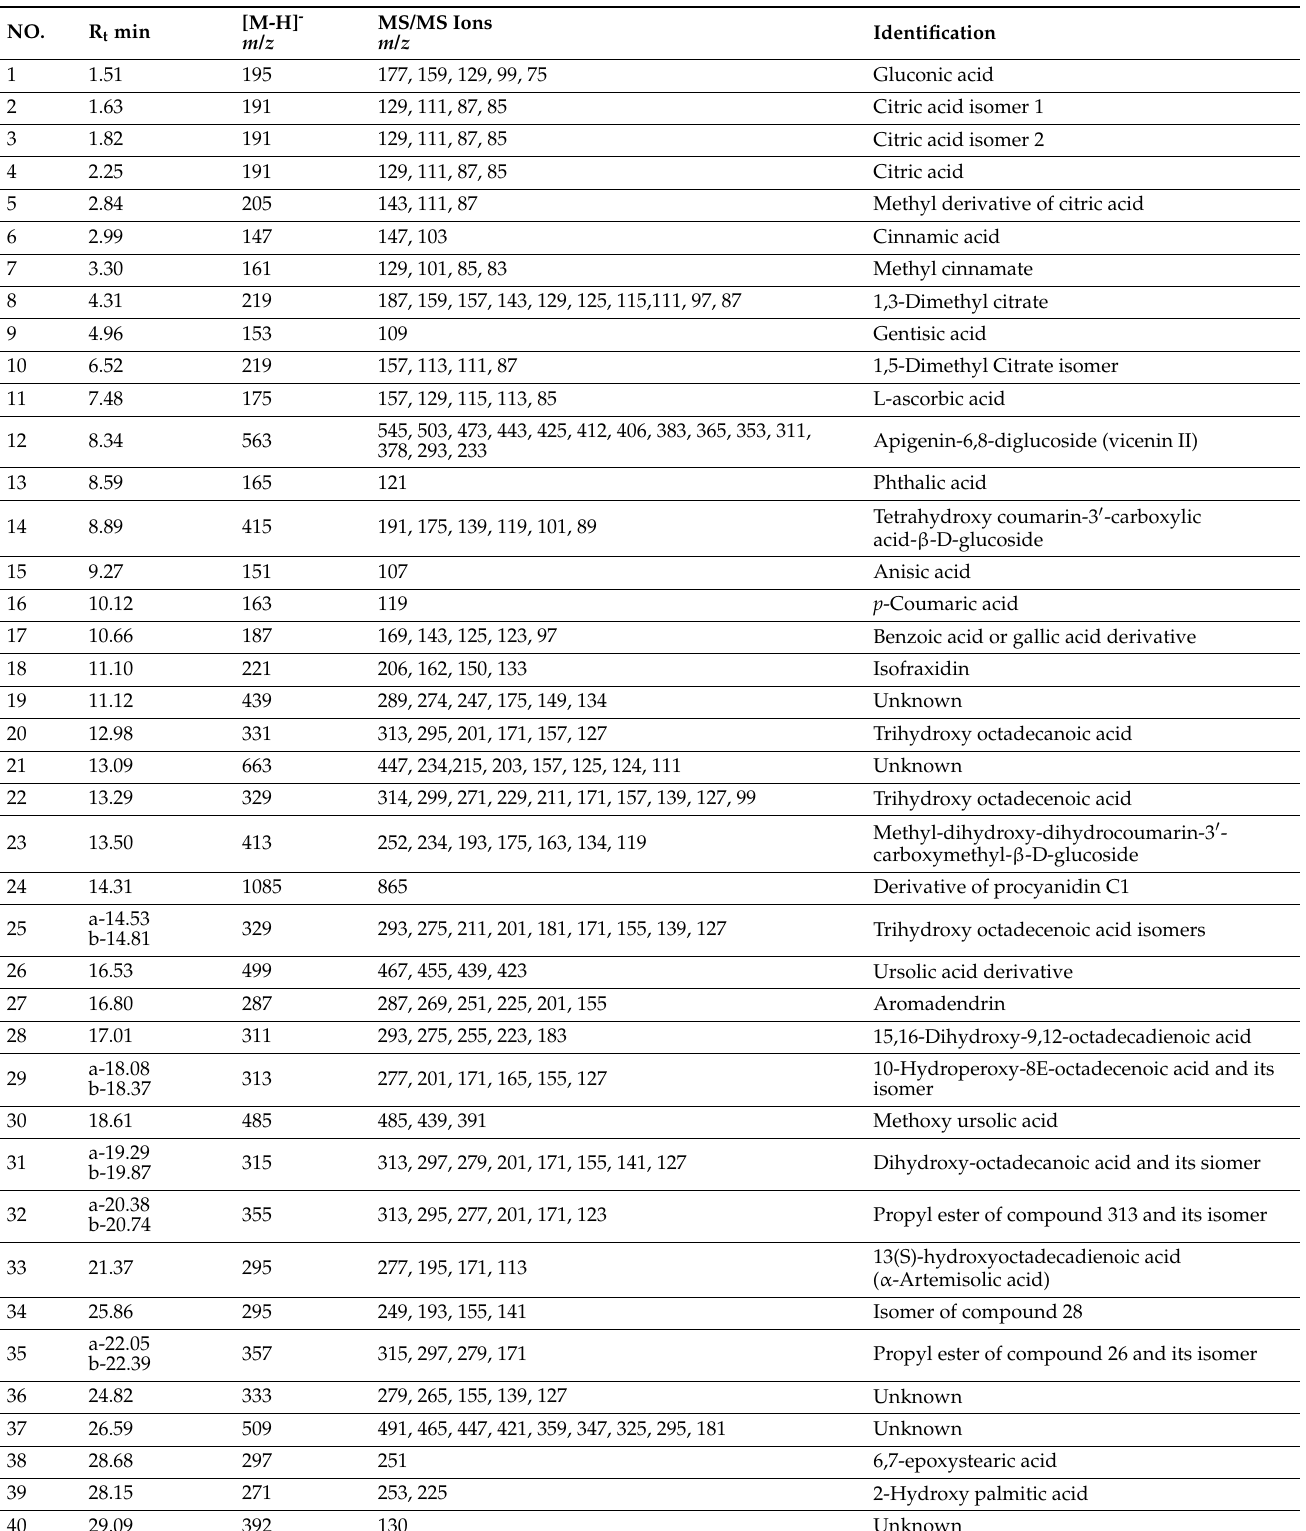
Table 2. UPLC-PDA-MS/MS profiling data for A. awamori